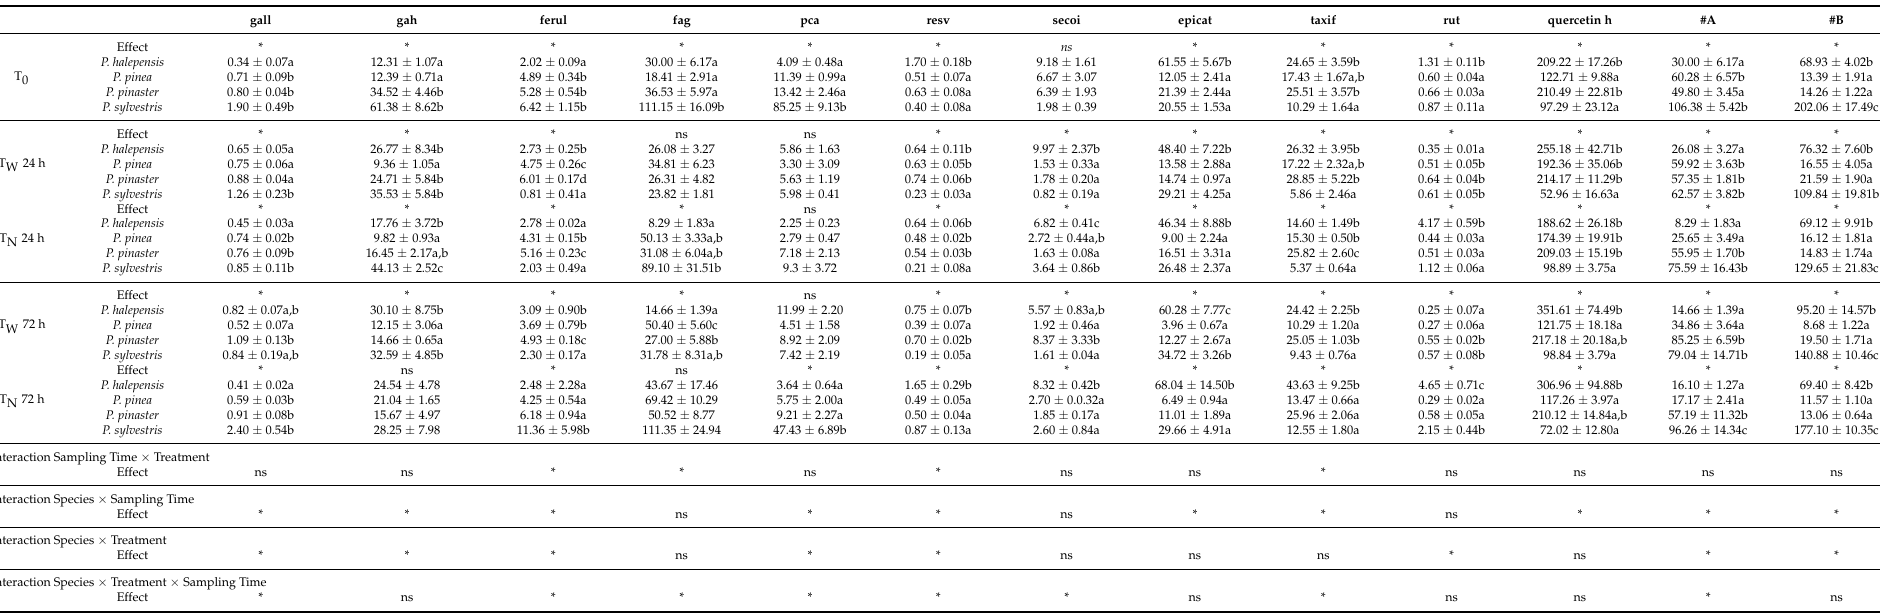
Table 1. Mean concentration of phenolic compounds according to sampling time and treatment in four pine species (mg/L).